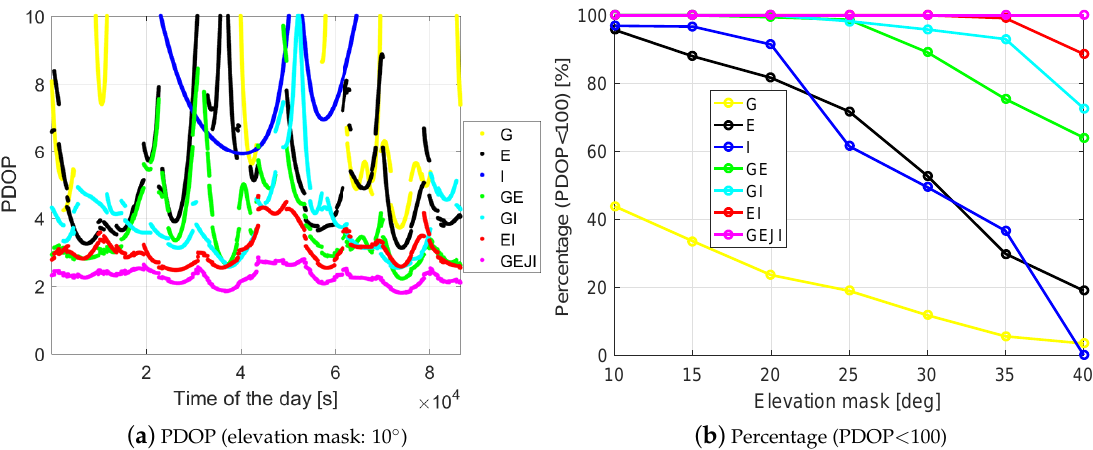
Figure 4. PDOP (Equation (6)) with an elevation mask of 10 degrees ( a ) and the percentages within a 24 h period that PDOP is smaller than 100 ( b ). The ground truth of baseline CUAA-CUCC and the satellite geometry on DOY 224, 2018 were used for the plots. Satellite positions (WGS84) of J07 on DOY 154, 2018 were used for the plots. The data sampling rate is 1 Hz. Note that ( a ) is zoomed out to 0–10.